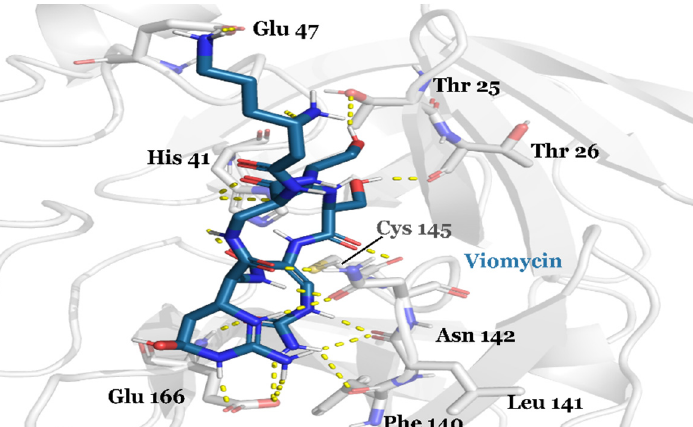
Figure 1. A representative snapshot of the docking pose of viomycin. M pro ’s residues are colored according to the atom type of the interacting amino acid residues (protein’s carbon, light grey; oxygen, red; nitrogen, blue). The protein–ligand interactions are represented by dash lines as follows: hydrogen bond interactions are colored in yellow.